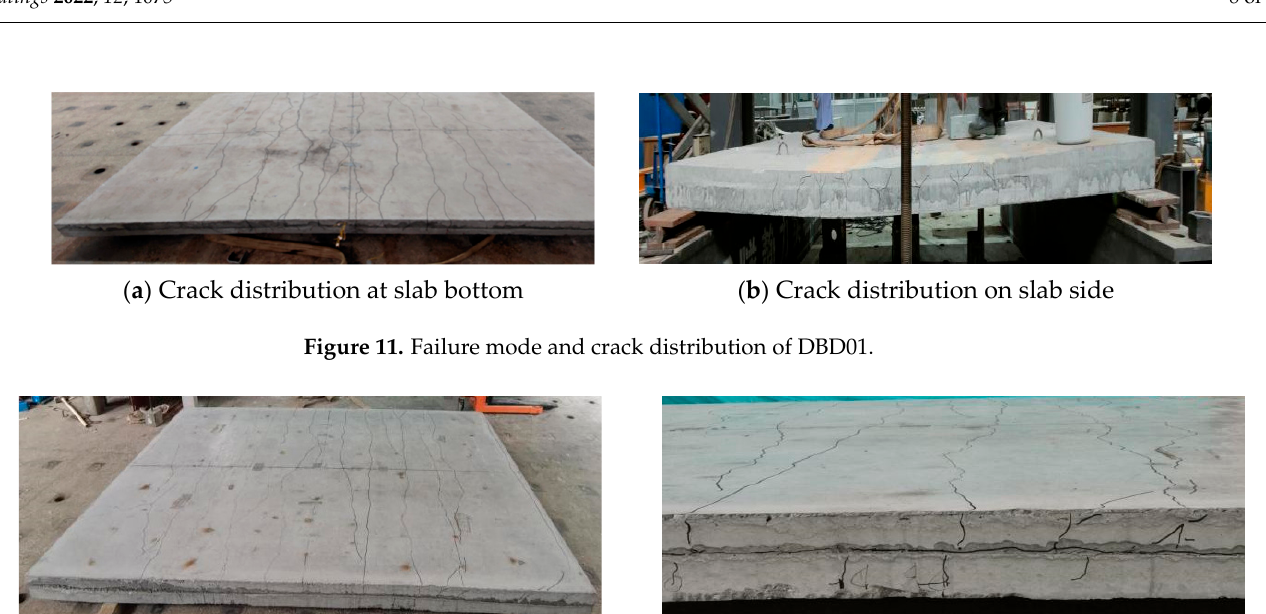
( b ) Top of the floor slabs Figure 9. Layout of measurement points for reinforcement strain gauges (unit: mm). ( a ) Side of the floor slabs ( b ) Bottom of the floor slabs Figure 10. Layout of measuring points of concrete strain gauge (unit: mm). 3. Results and Discussions 3.1. Failure Characteristics The mid-span deflection, steel bar, and concrete strain increase slightly when the load is small. The first crack appears in the mid-span pure bending section with a load of 13 kN. At this time, the strain of steel bar, concrete, and the mid-span deflection increases slightly. Moreover, the cracks develop from the middle to both ends along the width with the load increases and mainly distributed symmetrically in the mid-span. Firstly, the cracks on the side of the slab extend vertically upward in mid-span, and then the bending shear diagonal cracks successively appear within 1/3 of the span as the load increases. The interface between vertical and inclined cracks is a superposition sur- face, and the inclination angle of cracks decreases gradually. When the load is 66 kN, the deflection reaches 17.20 mm, corresponding to the width of 0.26 mm. According to GB 50010-2010, the deflection and crack width limit in the normal use stage is L 0 /200 = 17 mm